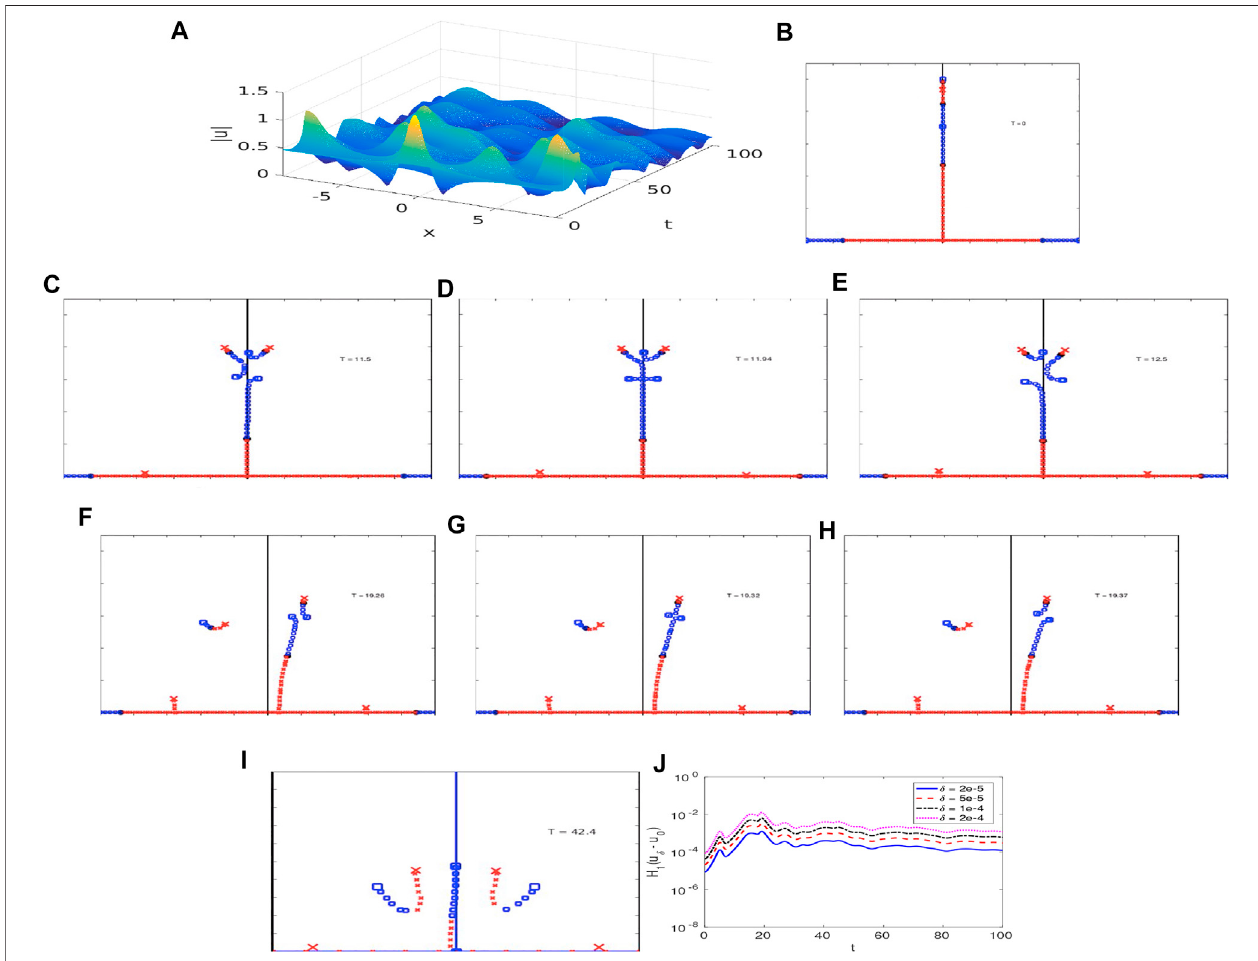
(cid:12)(cid:12)(cid:12)(cid:12)(cid:12) (cid:12)(cid:12)(cid:12)(cid:12)(cid:12) FIGURE 6 | Two UM regime: (A) U ( 1 ) ε , c ( x , t ) for 0 ≤ t ≤ 100, and spectrum at (B) t (cid:1) 0, (C) t (cid:1) 11 . 5, (D) t (cid:1) 11 . 94, (E) t (cid:1) 12 . 5, (F) t (cid:1) 19 . 26, (G) t (cid:1) 19 . 32, (H) t (cid:1) 19 . 37, (I) t (cid:1) 42 . 4, and J) η ( t ) for f 1 ( x , t ) , δ (cid:1) 10 − 5 , ... , 10 − 4